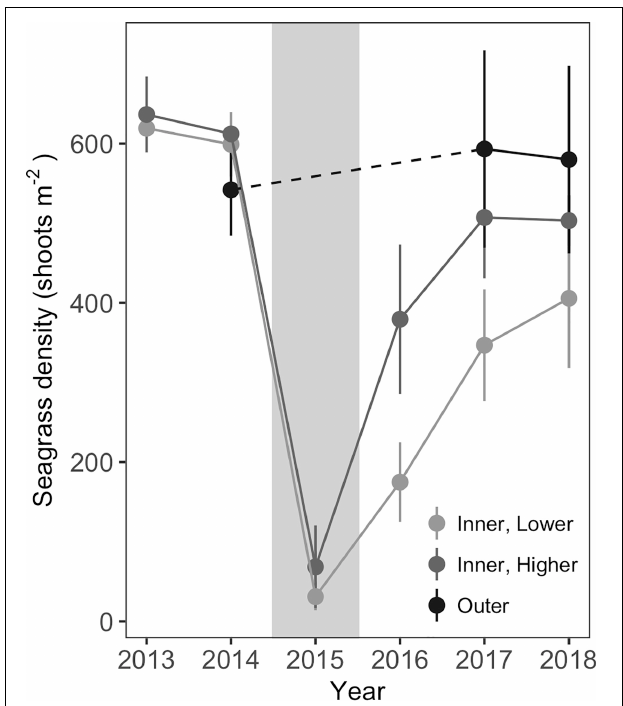
FIGURE 5 | Seagrass shoot densities at all inner and outer sites from 2013–2018. Densities are missing from outer sites in 2013, 2015, and 2016. In 2015, the year of the MHW disturbance, shoot densities declined at all inner sites. Sites with more rapid initial recovery were categorized as “higher” recovery sites; sites with lower initial recovery were considered “lower” recovery sites. Gray background indicates the year of the MHW. Values are mean ± 2 × SE, n = 3 each for inner, higher and inner, lower sites, n = 6 for outer sites.